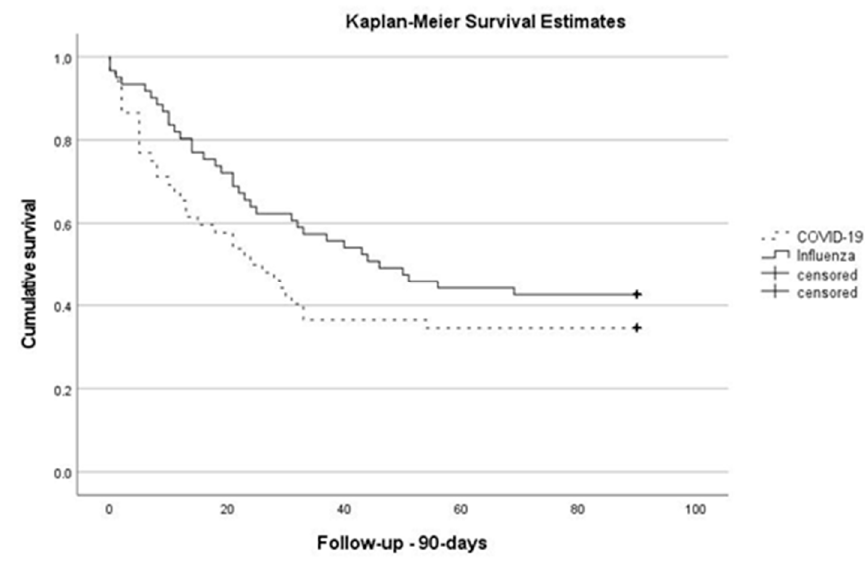
Figure 2. Kaplan–Meier 90 ‐ days survival estimates (log rank: p = 0.156) .